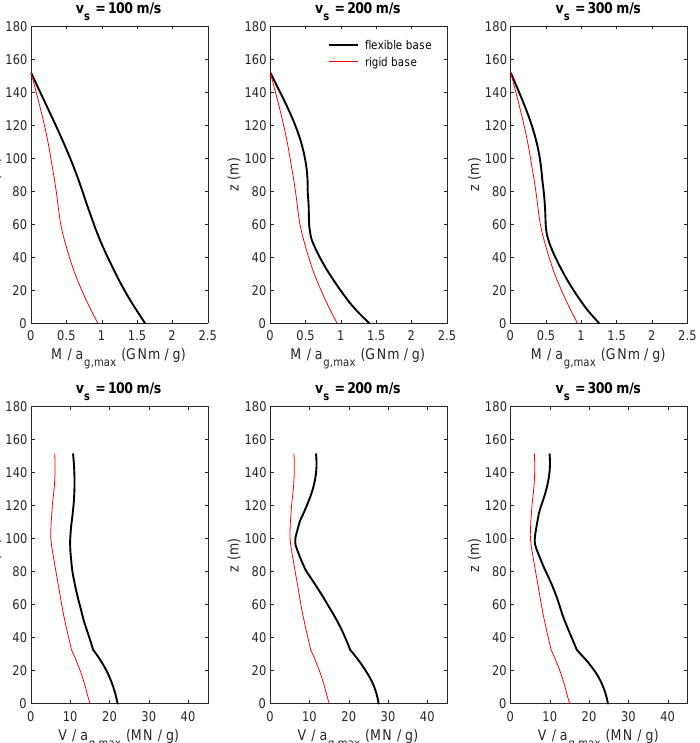
Figure 3. Mean envelopes of maximum seismic internal forces along the superstructure depend- ing on soil properties. 10 MW. Comparison of the response obtained from the flexible and rigid base assumptions.